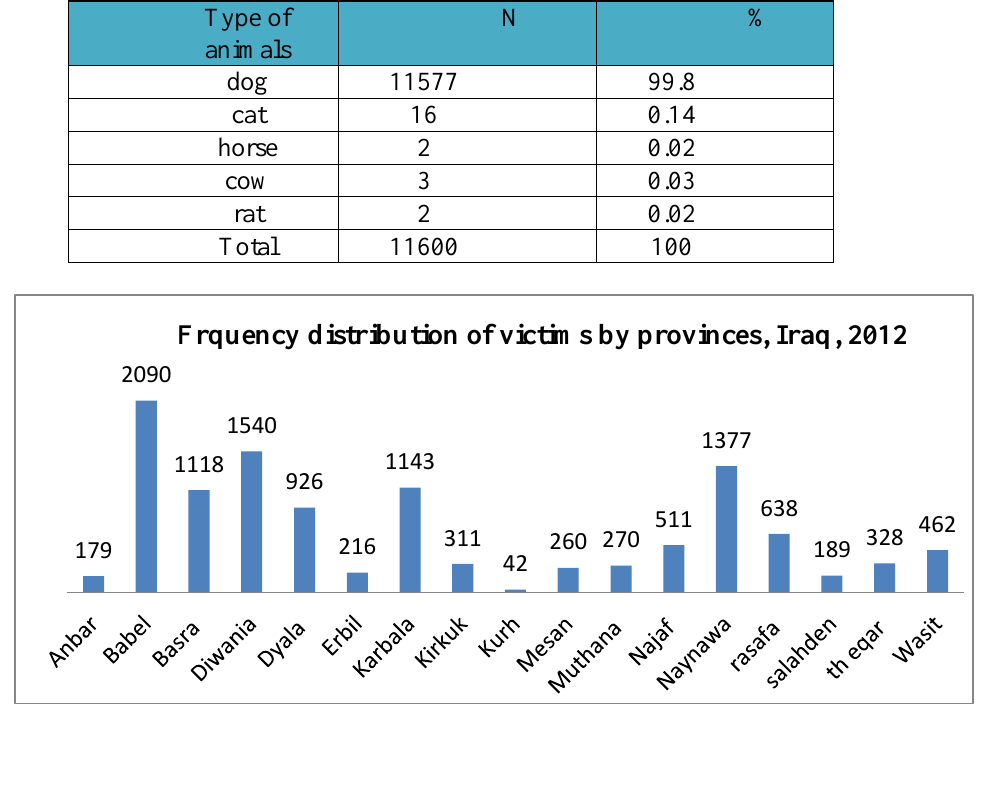
Table (2): Study sample distribution by types of